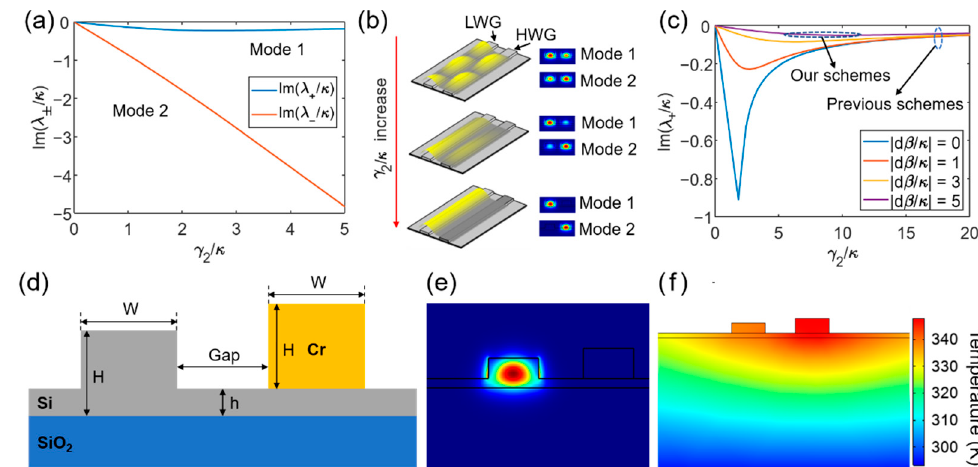
Figure 1. ( a ) The imaginary parts of λ ± / κ vary with γ 2 / κ when | d β / κ | = 1. ( b ) Schematic diagrams of the eigenmode distribution and the propagation field as γ 2 / κ increases. ( c ) The imaginary part of λ + / κ vary with γ 2 / κ at different | d β / κ |. ( d ) Simplified cross-sectional diagram of the phase shifter, not to scale. W = 500 nm, H = 220 nm, h = 70 nm, Gap = 350, 450, and 550 nm. ( e ) Simulated optical E field distribution for the fundamental mode at a wavelength of 1550 nm (Gap = 450 nm). ( f ) Simulated temperature distribution at P π = 25.1 mW (Gap = 450 nm).